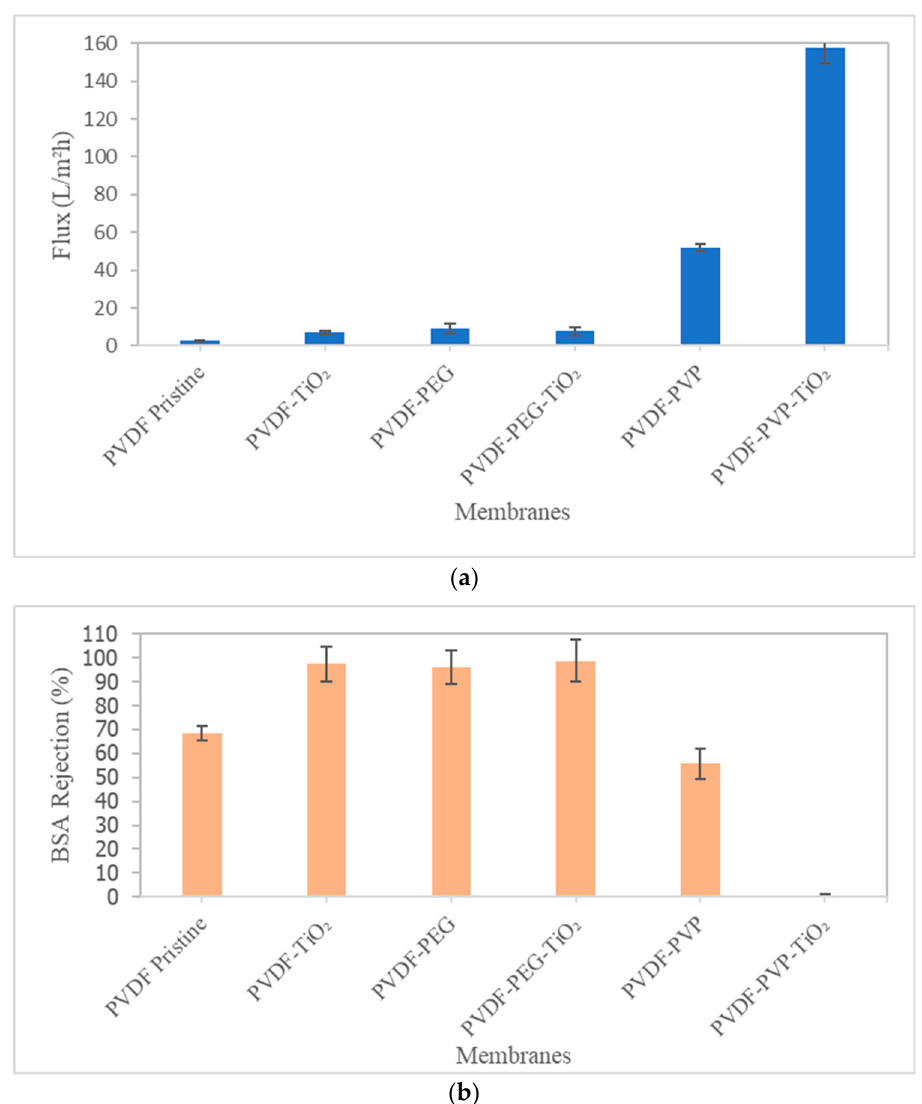
Figure 7. ( a ) BSA solution flux of membranes. ( b ) BSA rejection of membranes.